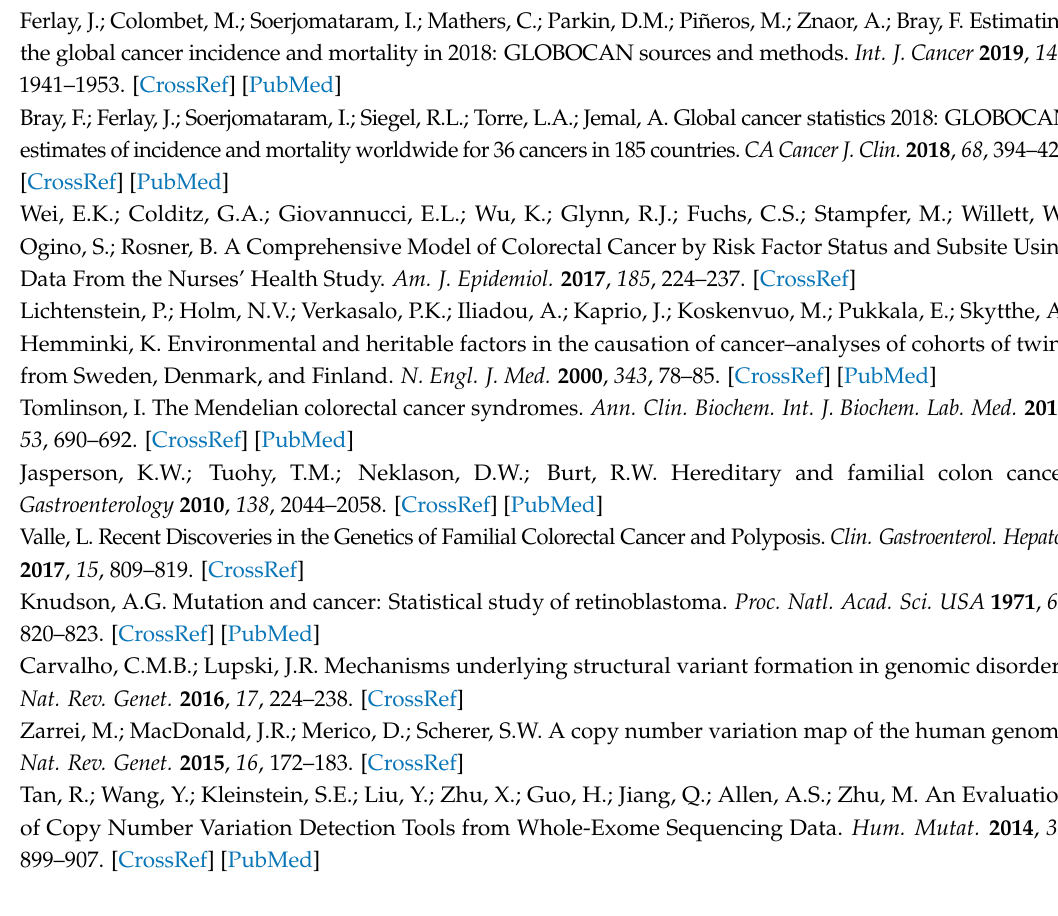
Figure S1: histogram representing the percentage of genomic regions with a high-quality value of coverage ( ≥ 10 × ) with respect to all shared sequenced regions for each of the germline–tumor paired samples, Figure S2: pedigrees of the 18 families included in the study, Table S1: description of germline copy number variants after calling by CoNIFER and ExomeDepth, Table S2: description of genes and germline variants of the cases where a potentially pathogenic germline SNV/indel and tumor LOH were identified, Table S3: list of potentially pathogenic rare germline variants found in a cohort of 1006 familial early onset CRC patients corresponding to CanVar